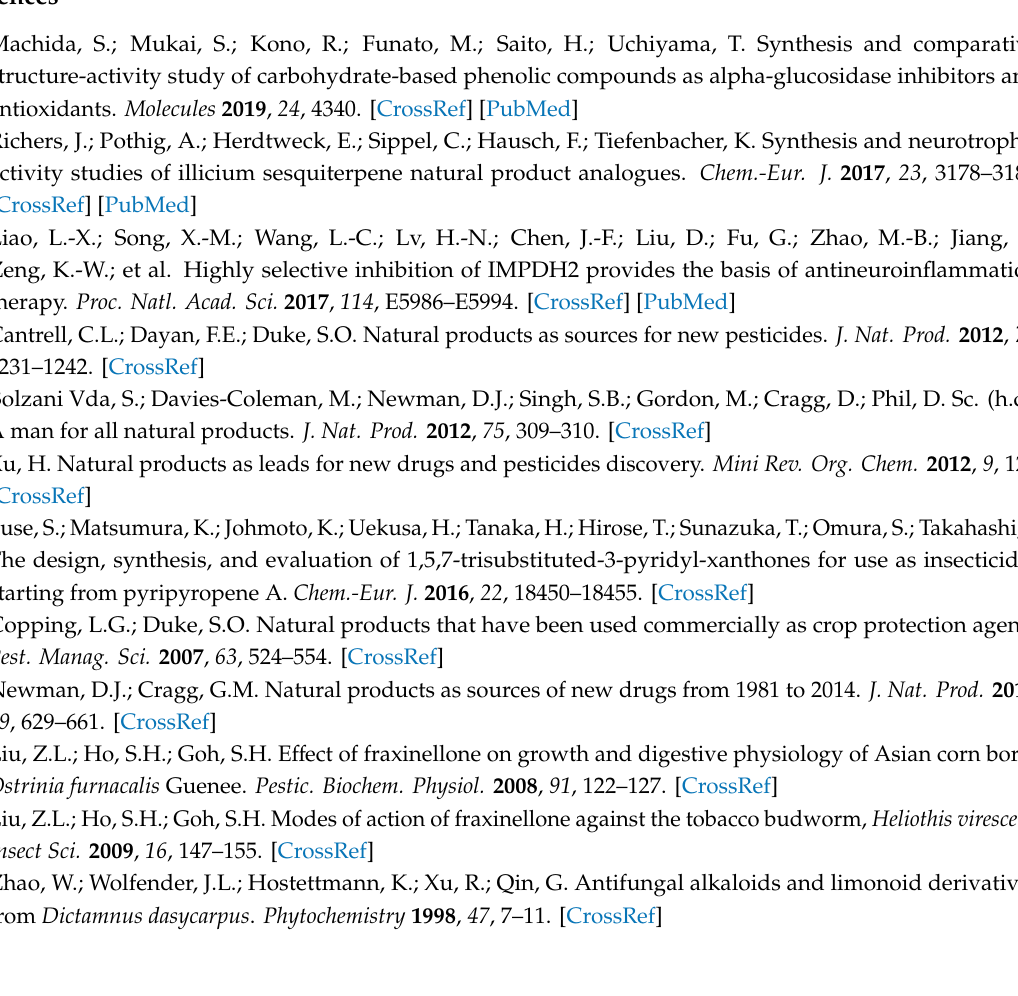
Supplementary Materials: The following are available online, Figure S1–S5: NMR spectra of compounds 2b , 2c